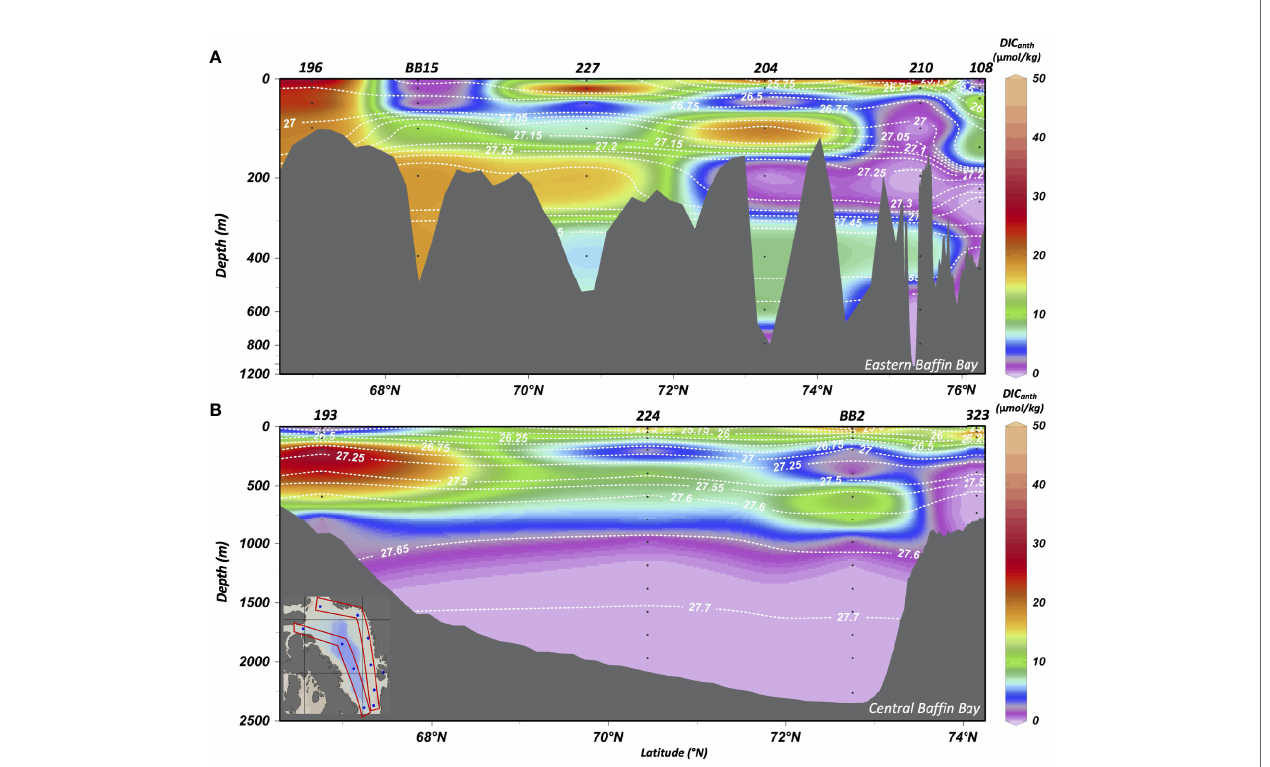
FIGURE 5 | Calculated DIC anth concentrations found throughout central and Eastern Baf fi n Bay. Distributions of DIC anth concentrations plotted from two transects along (A) the west coast of Greenland and (B) central Baf fi n Bay, as indicated by the inset on b). DIC anth concentrations calculated based on methods by Lee et al. (2003). DIC anth values <5µmol kg -1 are assumed to contain zero DIC anth (See Estimation of Anthropogenic (DIC anth ) and “ Bomb ” DIC 14 C ). Sample depths and locations are indicated by black dots, with station names labelled at the top of the plots. Dashed white contours are density anomaly ( s q in kg m -3 ) isopycnals. We note that Ocean Data View interpolations of DIC anth (from n=11 stations) are meant for interpretation and do not re fl ect an accurate spatial distribution of DIC anth